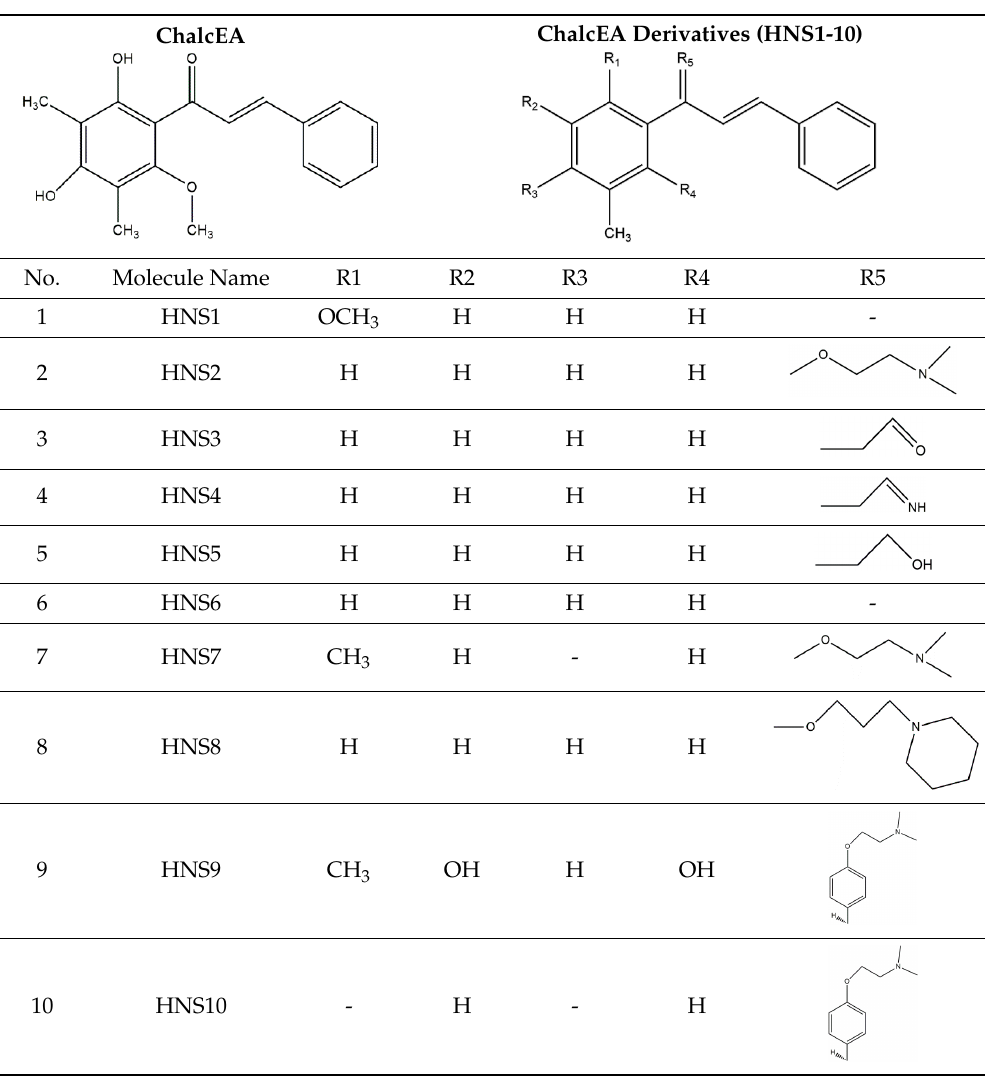
Table 2. Computed standard properties of ChalcEA derivatives based on Lipinski’s Rule of Five. HB indicates hydrogen bond.